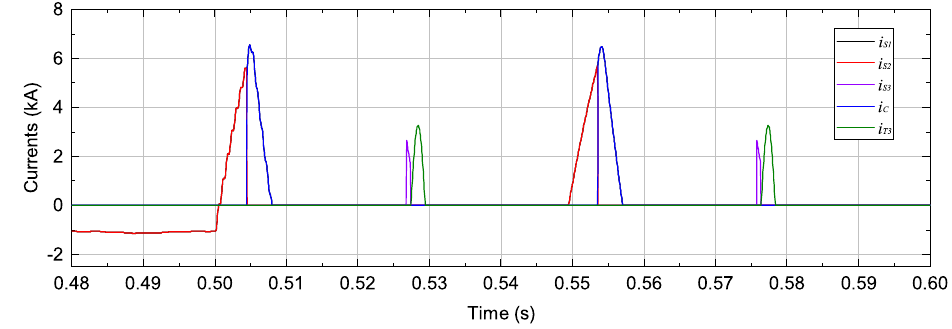
Figure 15. Overall currents on the switches of HCB 3.